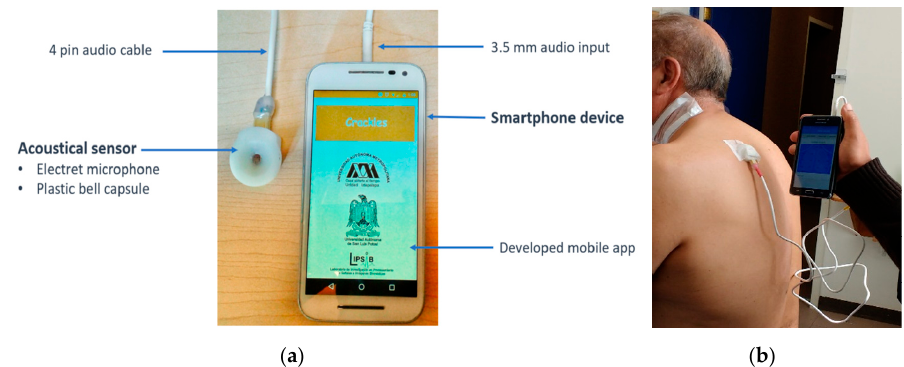
Figure 1. ( a ) Smartphone-based system developed for the automatic detection of respiratory crackle sounds for displaying, processing, and provide crackle detection results, ( b ) Acquisition at bedside of a patient diagnosed with diffuse interstitial pneumonia.